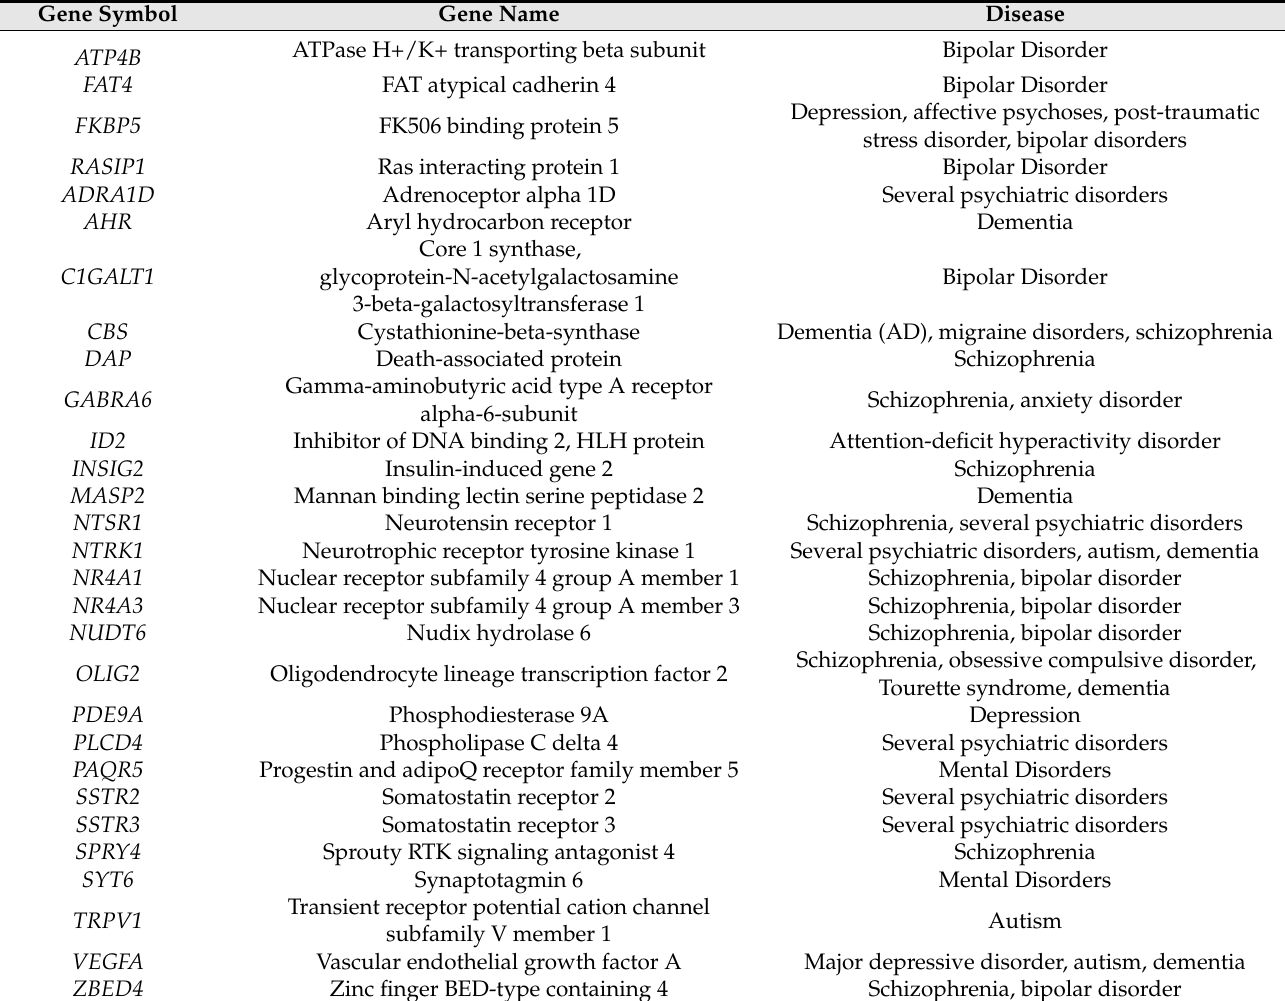
Table 2. Disease genes from the “psychiatric disease” family and related